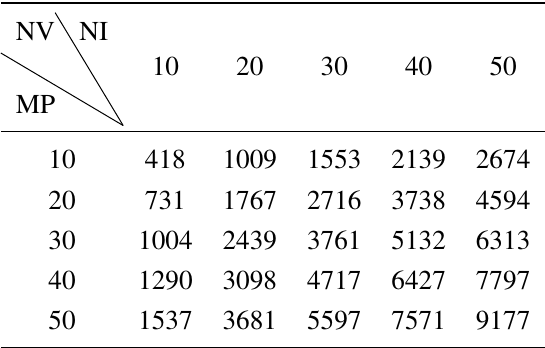
Table 1. The result of efficiency